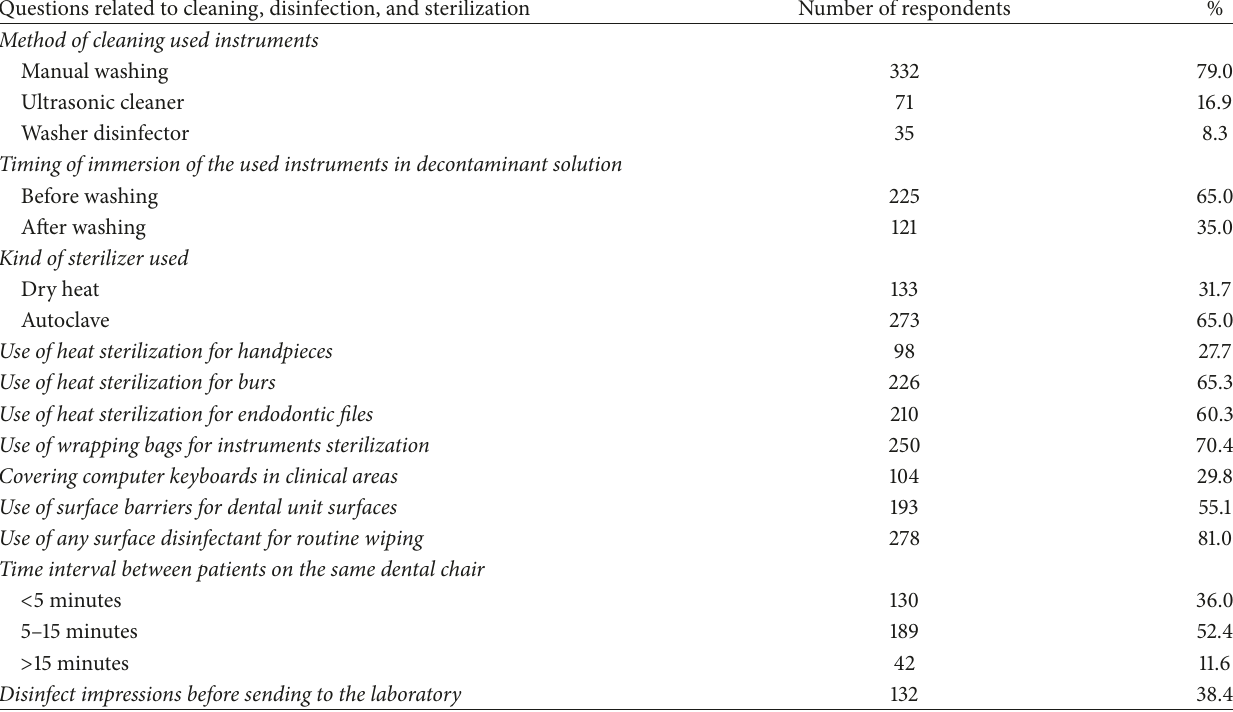
Questions related to cleaning, disinfection, and sterilization